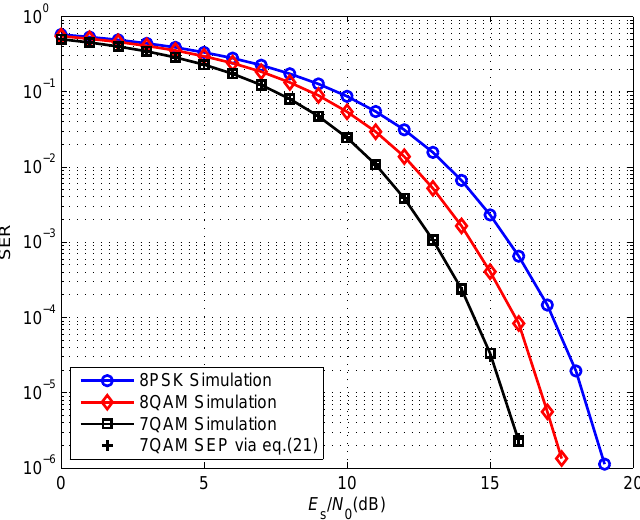
Figure 6. SER performance of different modulations over the AWGN channel without channel coding and the average SEP of 7-QAM.